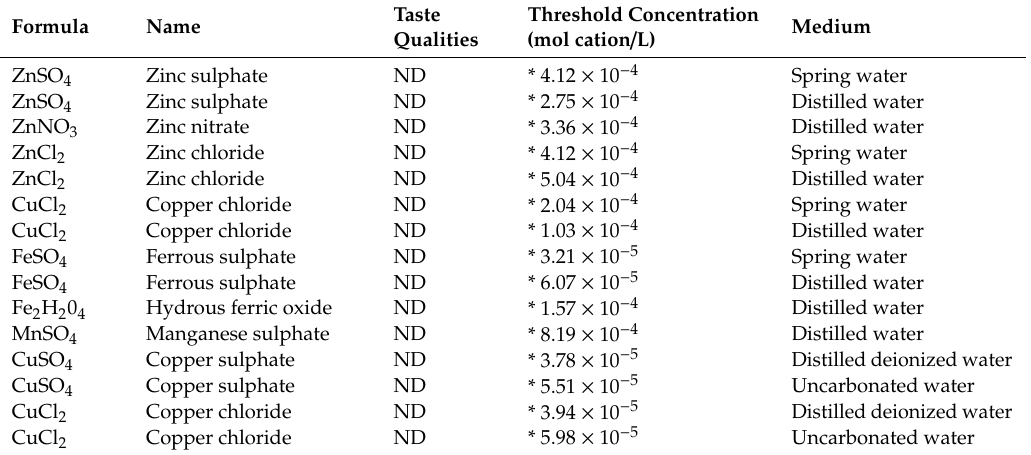
Table 5. Taste qualities and threshold of cations (mol cation / L) in di ff erent medium with or without nose-clip